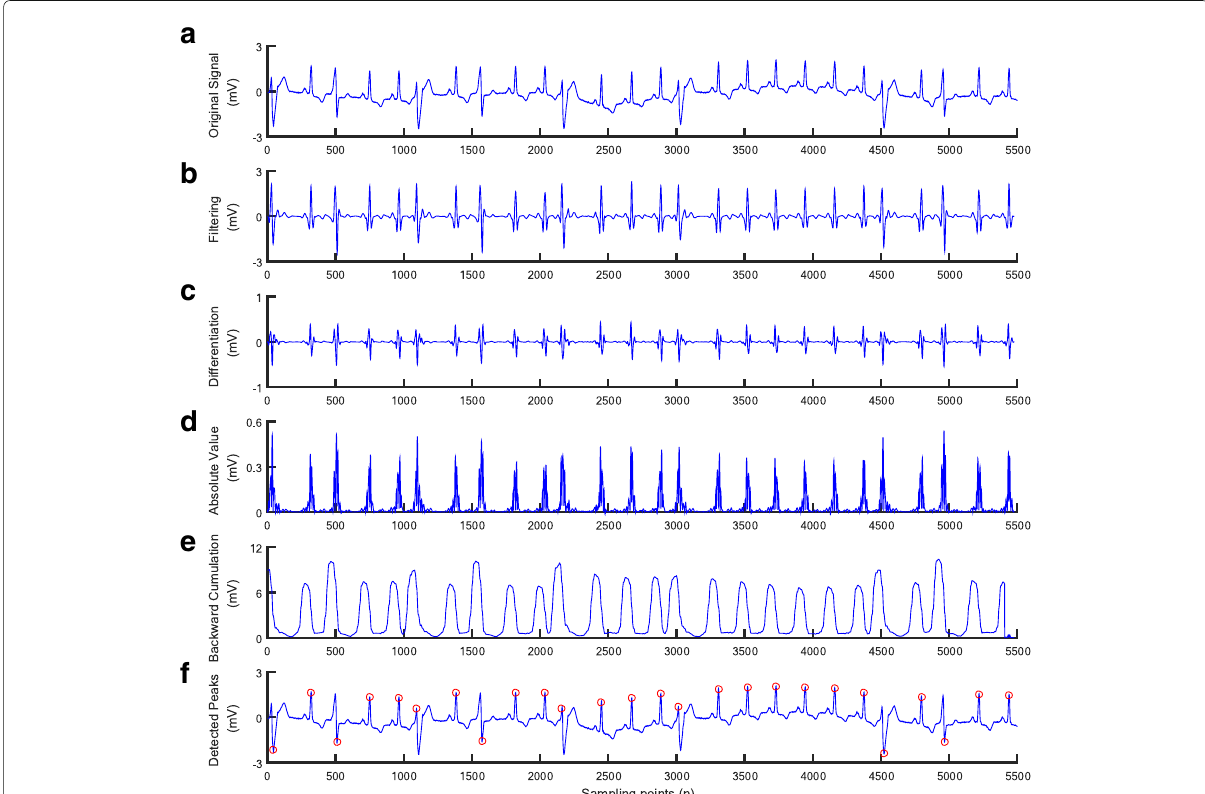
Fig. 9 Result after performing each stage of the method for the ECG with ventricular arrhythmia patterns(ECG recording 233). a ) Original signal. b ) Filtering. c ) Differentiation. d ) Absolute value. e ) Backward cumulation. f ) Detected